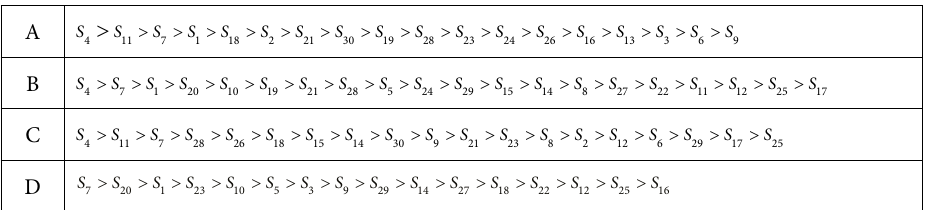
Table 15. Rank of potential suppliers for the components